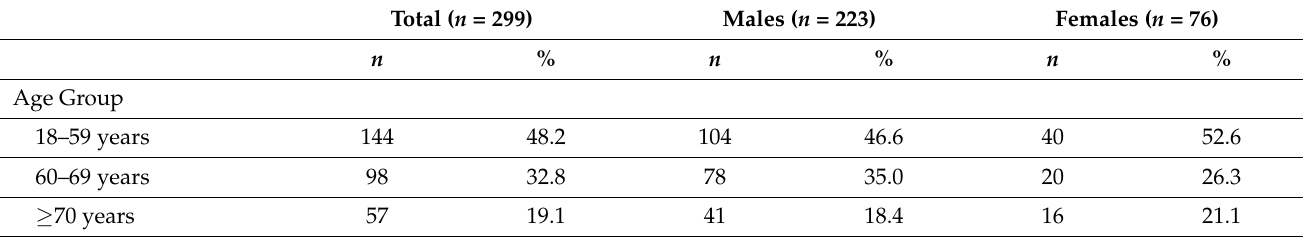
Table 1. Patient